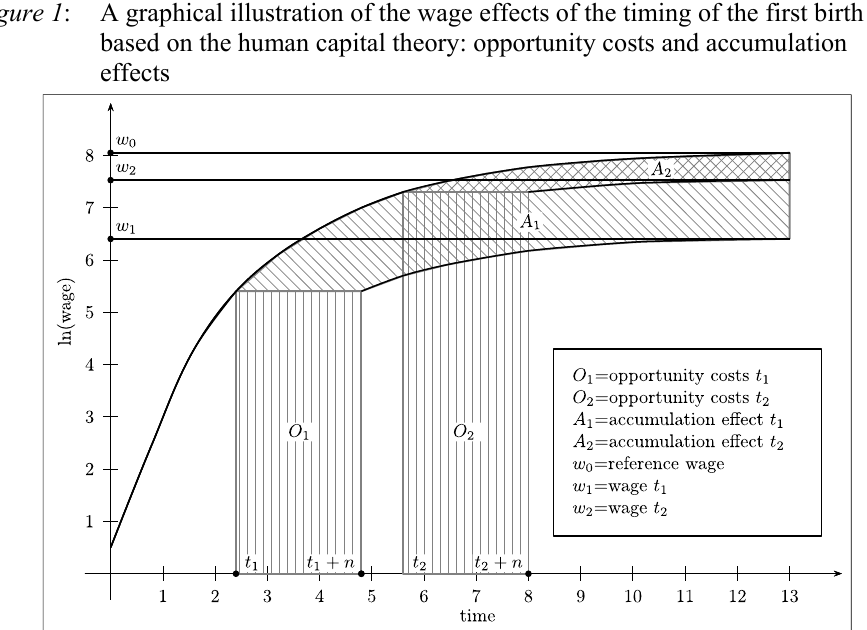
Figure 1 : A graphical illustration of the wage effects of the timing of the first birth based on the human capital theory: opportunity costs and accumulation